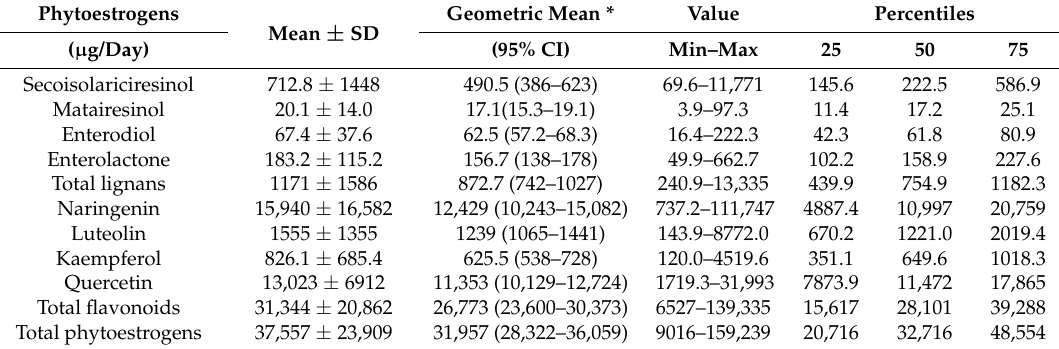
Table 2. Lignan, flavonoid, and total phytoestrogen intakes estimated by the FFQ in Mexican women ( n =